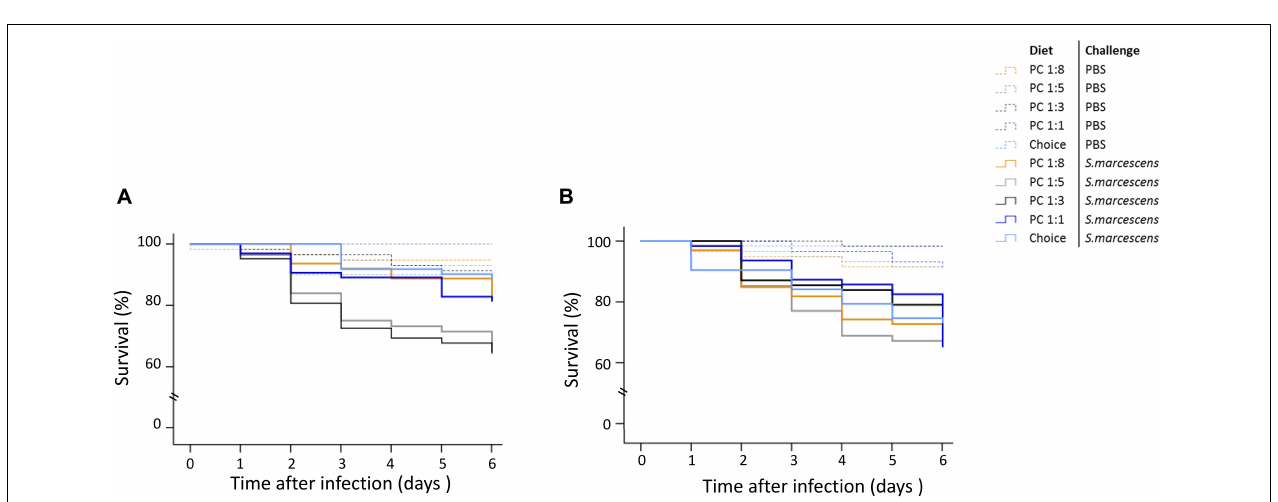
FIGURE 5 | Effect of parental diet on offspring survival during the first 6 days post septic infection. Both mother and fathers were fed one of five diets varying in the protein-to-carbohydrate ratio (PC ratio). Their sons (A) and daughters (B) were injected with either PBS or Serratia marcescens at adult stage. Lines indicates Kaplan–Meier survival curves [dash lines (non-infected flies), continuous lines (infected flies). Colours indicate parental diet treatments [orange (PC 1:1), light grey (choice diet), dark grey (PC 1:3), dark blue (PC 1:5) and light blue (PC 1:8)]. Significant differences between survival curves were determined by Cox regression analysis and was determined at P <